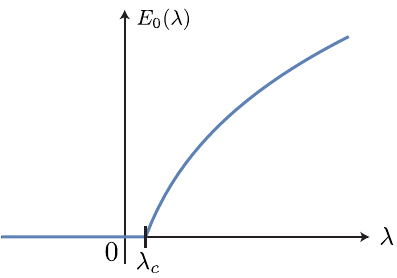
Figure 5. Threshold energy E 0 as a function of λ for ( α 1 , α 2 ) = (1 / 4 , 1 / 3) , obtained by numerically solving (3.19). For λ = λ c in (3.15) we observe a first order phase